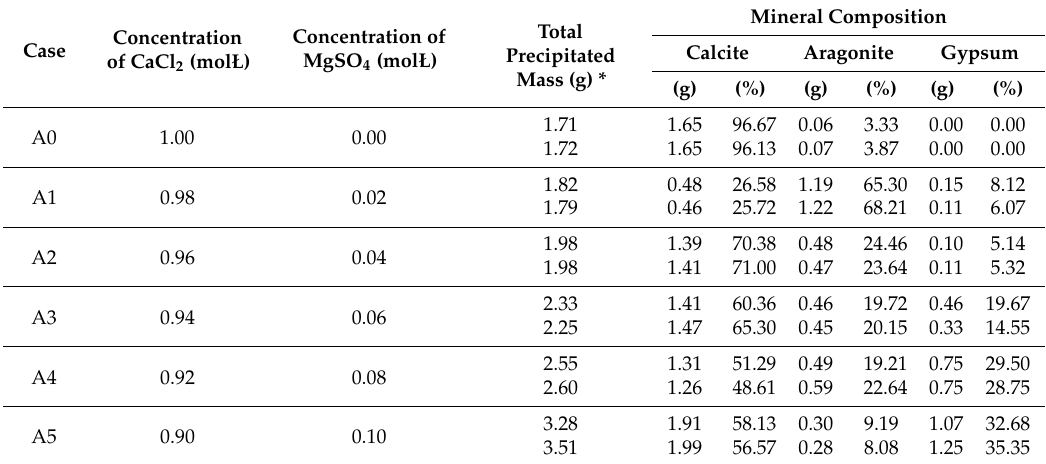
Table 3. Amount and composition of precipitated materials.